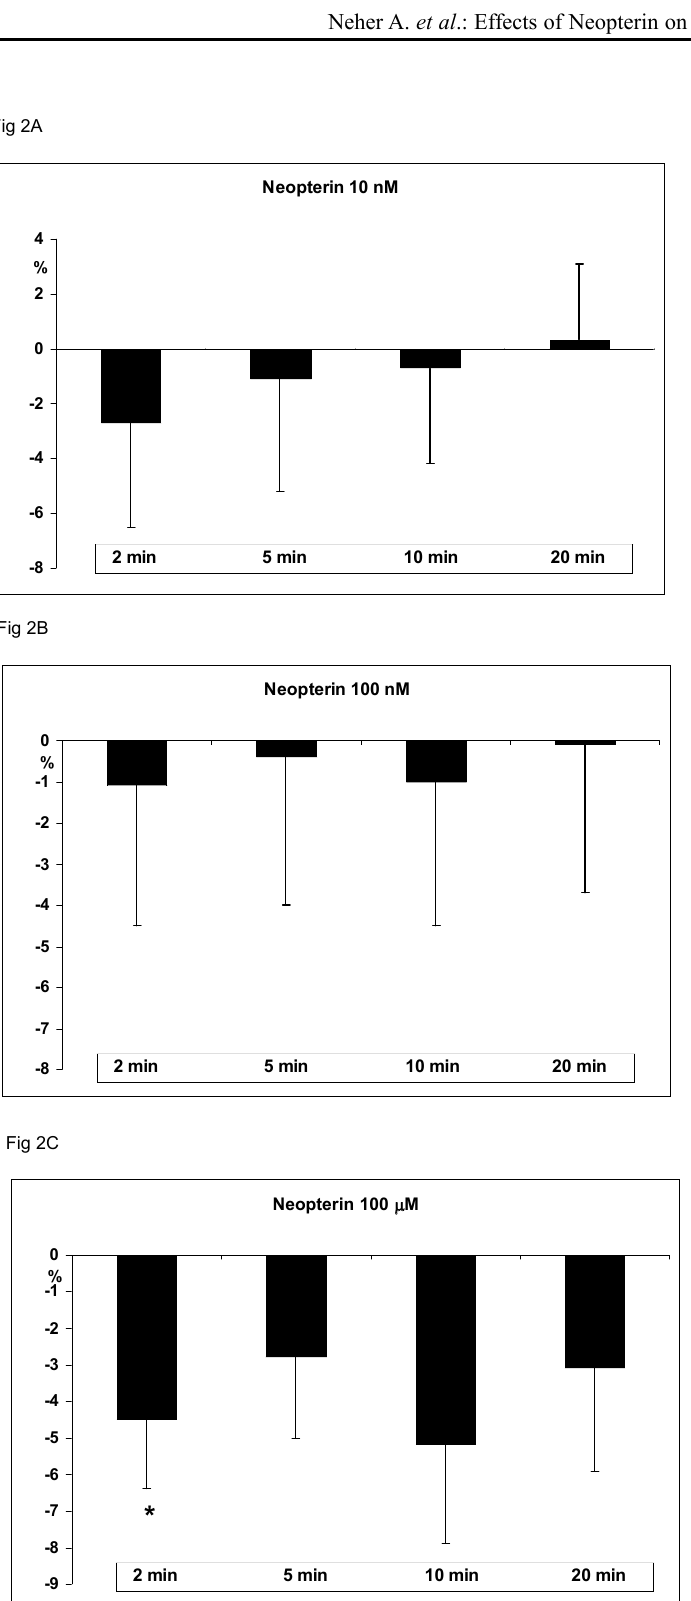
Figure 2: Time dependent changes (2 min, 5 min, 10 min, 20 min) of ciliary beat frequency after incubation of human nasal ciliary cells with neopterin 10 nM (fig. 2A), 100 nM (fig. 2B) or 100 µ M (fig. 2C). Data were cal- culated as percentual changes between test substances and baseline. Results are given as mean values ± SEM. Asterisks indicate p < 0.05 as compared to baseline data without test substances (Wilcoxon